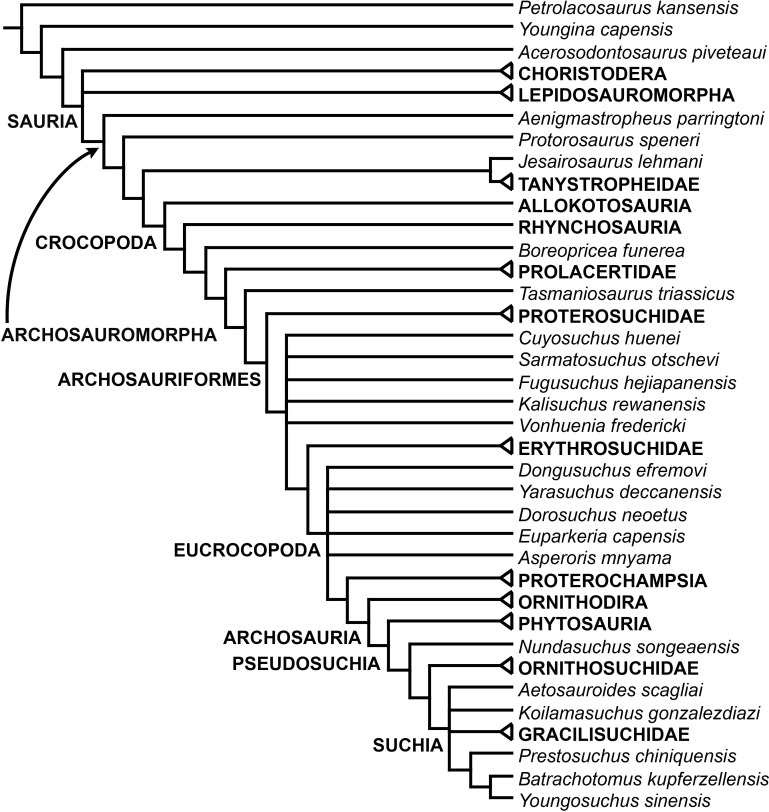
Second strict reduced consensus tree recovered from analyses 1 and 2.Some clades have been condensed into suprageneric terminals to simplify the figure and their internal relationships are the same as in previous figures.